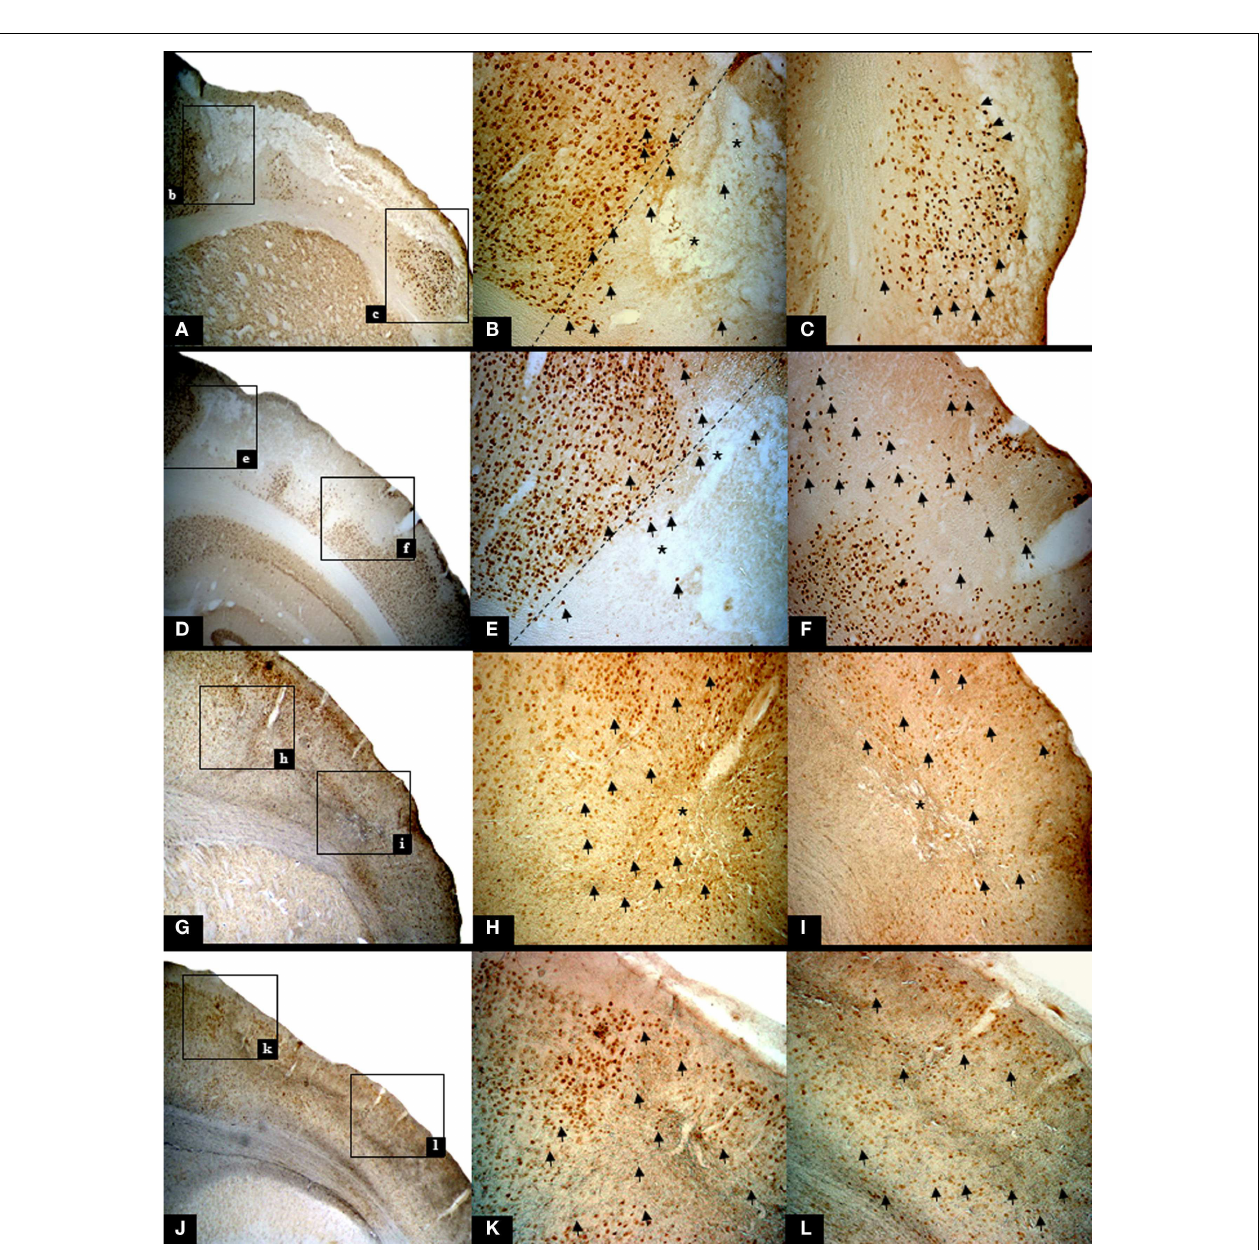
thinning; ( D ) Partial infarction (bregma -6.04mm).The following features are highlighted: confluent areas of complete loss of staining, representing extensive neuronal death and nuclear pyknosis [arrows; (E,F) ] with fewer cavitations [*; (E) ] in the core, with a peripheral rim of SNL. Note that the extracellular matrix shows deteriorated cytoarchitecture. (G) Partial infarction in a rat subjected to 22min MCAo (bregma + 1.00mm). Confluent areas of karyolysis, karyorrhexis, pyknosis [arrows; (H,I) ], and some areas of SNL with cavitations (*) in the core. (J) Light microscopic histological analysis of brain sections from the same rat highlighting areas of SNL (bregma -6.04mm). Note the presence of nuclear pyknosis [arrows; (K,L) ].